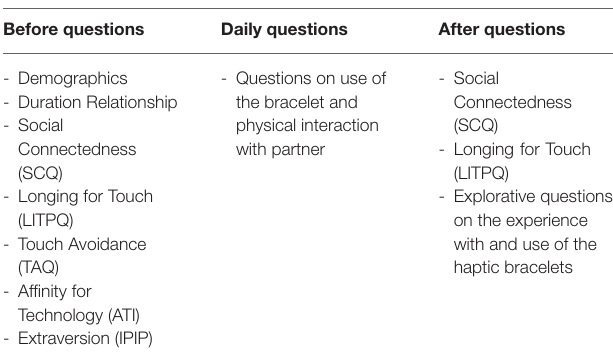
TABLE 1 | Sequence of the three sections of questions as shown to participants in the HowAmI app. Before